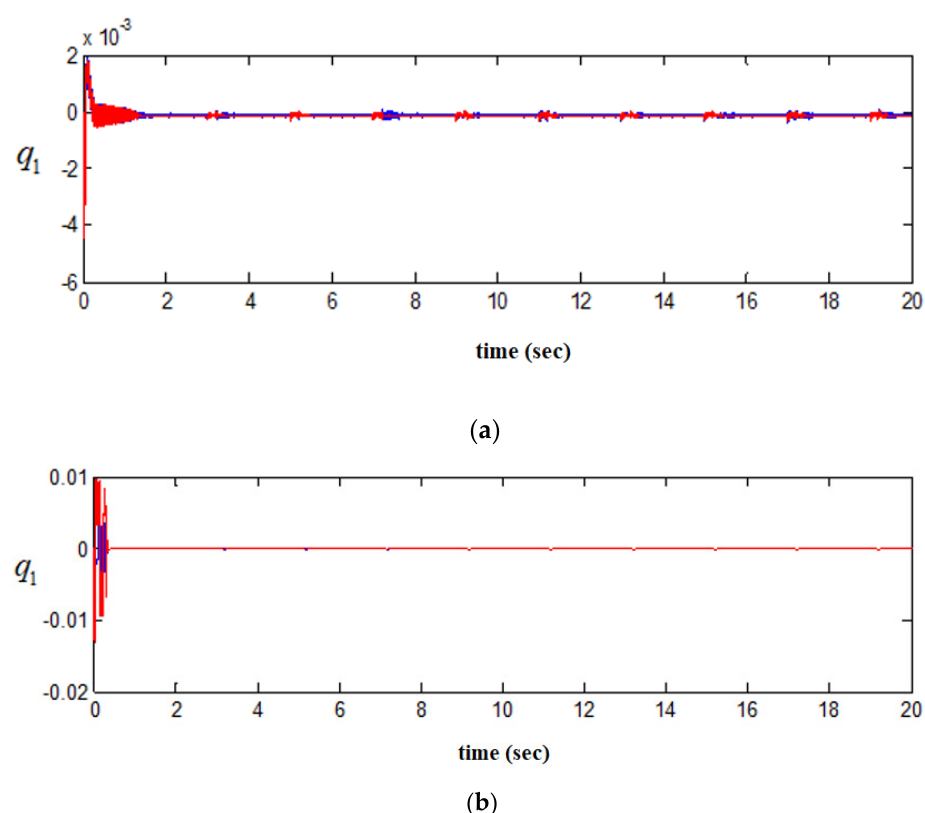
Figure 6. ( a ) The set-point control performance of the PD based adaptive control laws; ( b ) the set- point control performance of the proposed SMC-based adaptive control laws for a step-type endpoint reference. (Blue: with torque ripple, Red: without torque ripple).